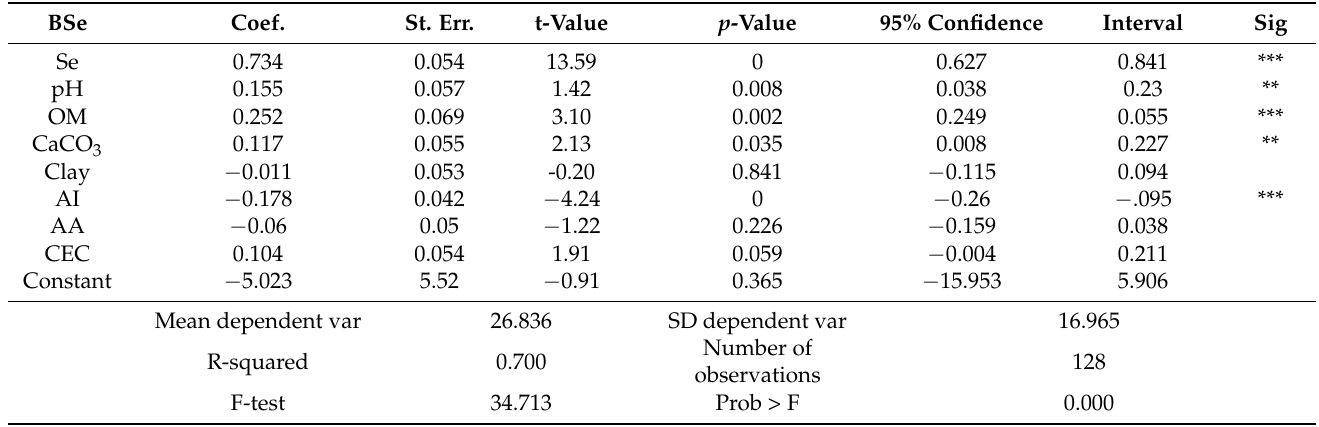
Table 3. Results of multiple linear regression analyses for the dependence of bioavailable